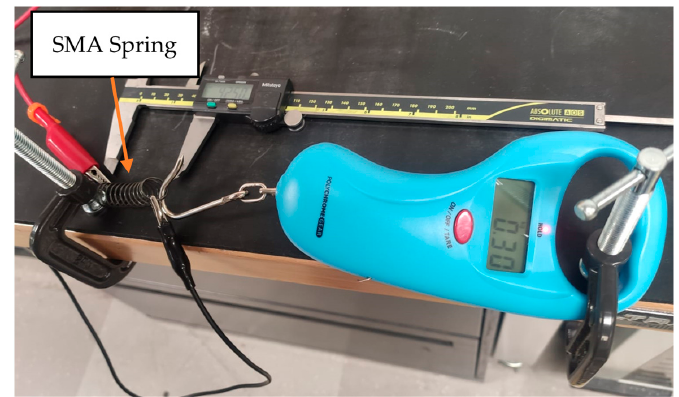
Figure 5. Setup for SMA spring load capacity test.